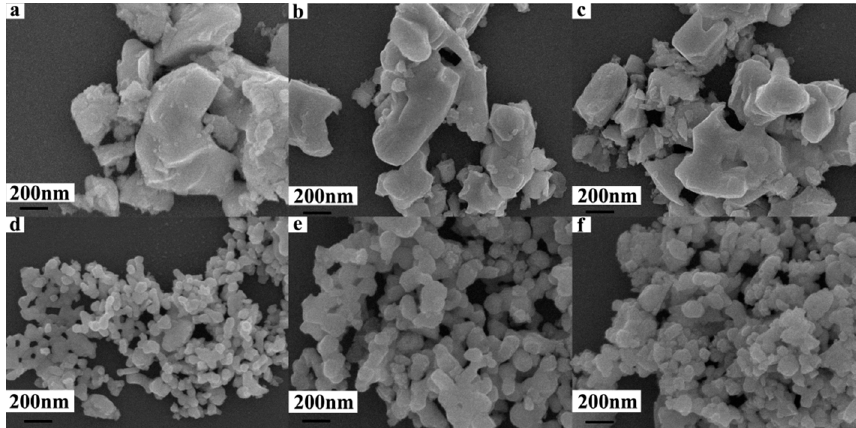
Figure 6. FE-SEM images of La 0.8 Sr 0.2 MnO 3 powers. ( a ) LSM (0 h), ( b ) BM-LSM (12 h), ( c ) BM-LSM (24 h), ( d ) BM-LSM (36 h), ( e ) BM-LSM (48 h), ( f ) BM-LSM (60 h). BM =